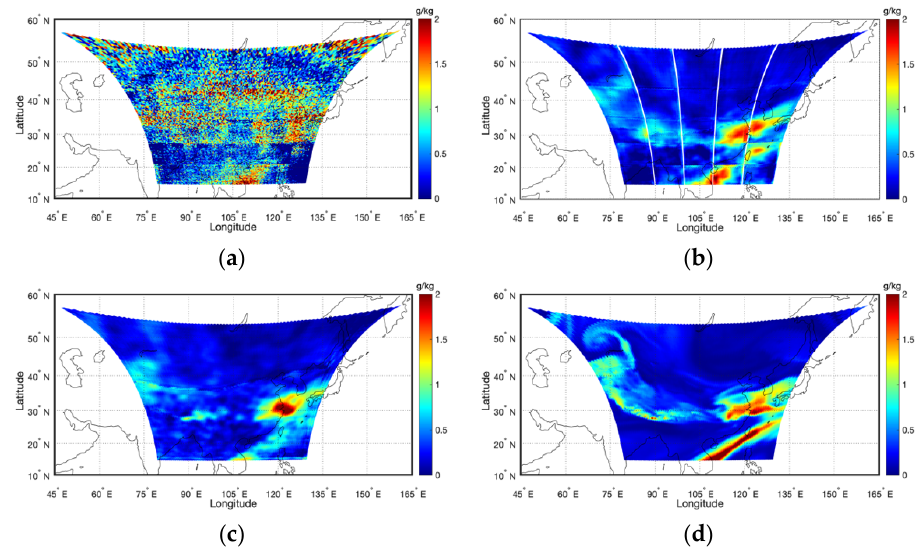
Figure 9. Same as Figure 8 except for 500 hPa: ( a ) 1D ‐ Net; ( b ) U ‐ Net 1; ( c ) U ‐ Net 2; ( d ) ERA5. To quantitative test the retrieval accuracy, the temperature and humidity ME (mean error) and RMSE (root mean square error) profiles from the three schemes and GIIRS L2 products compared with ERA5 reanalysis data for the whole February 2021 are given in Figures 10 and 11 respectively. The red lines are ME profiles, the black lines are RMSE profiles. The thicker dash ‐ dotted line represents the 1D ‐ Net scheme, the dashed line is the U ‐ Net 1 scheme, the solid line is the U ‐ Net 2 scheme, and the thinner dash ‐ dotted line represents the L2 operational products. Figure 10 shows that most of the heights of these schemes are positive bias except for U ‐ Net 2 from 750–150 hPa. The MEs of the two U ‐ Net schemes are within 1 K at all pressure levels. The bias of 1D ‐ Net scheme is significantly increased below 300 hPa. The RMSE of U ‐ Net 1 and U ‐ Net 2 are much smaller than 1D ‐ Net. U ‐ Net 2 scheme is better than that of the U ‐ Net 1 scheme at all pressure levels. The accuracy of L2 products is close to two U ‐ Net schemes below 700 hPa, but the RMSE